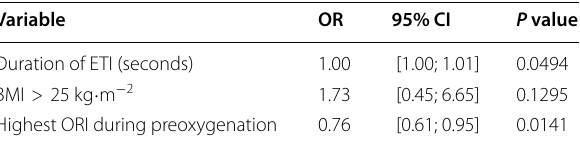
Table 3 Multivariable analysis: factors associated with SpO 97% during endotracheal intubation